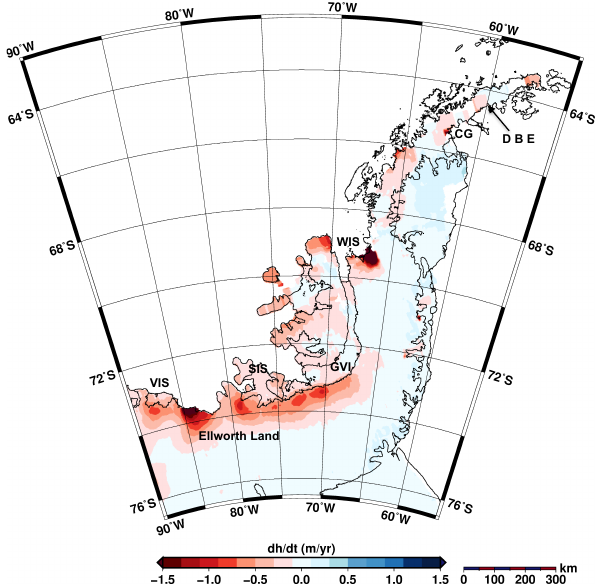
Figure 12. Elevation change occurring at the Antarctic